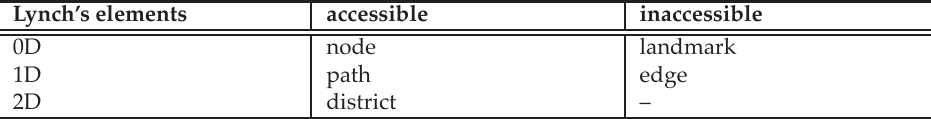
Table 2: Categorizing Lynch’s elements by accessibility and conceptual